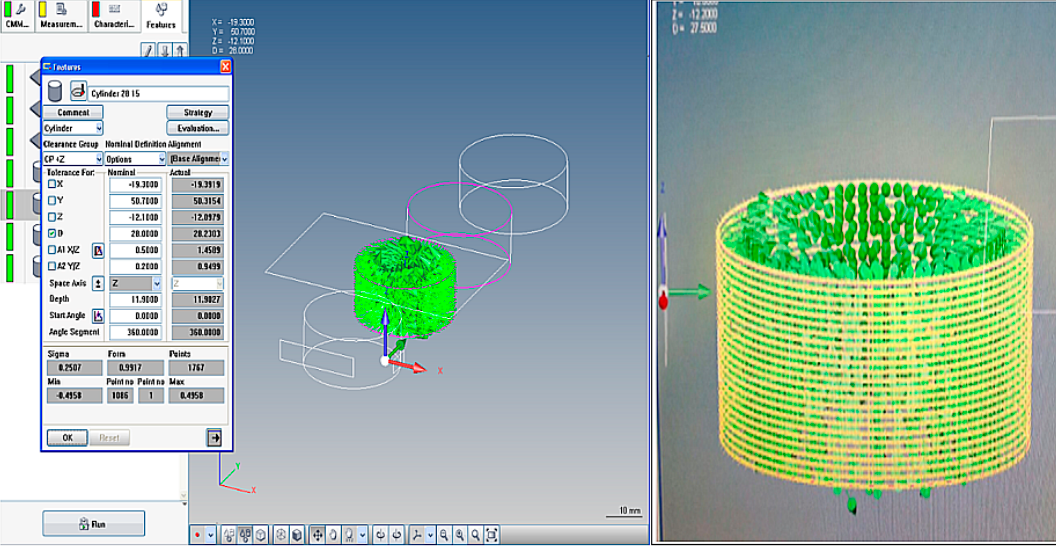
Figure 9. Measuring strategy adopted to compute the cylindricity.